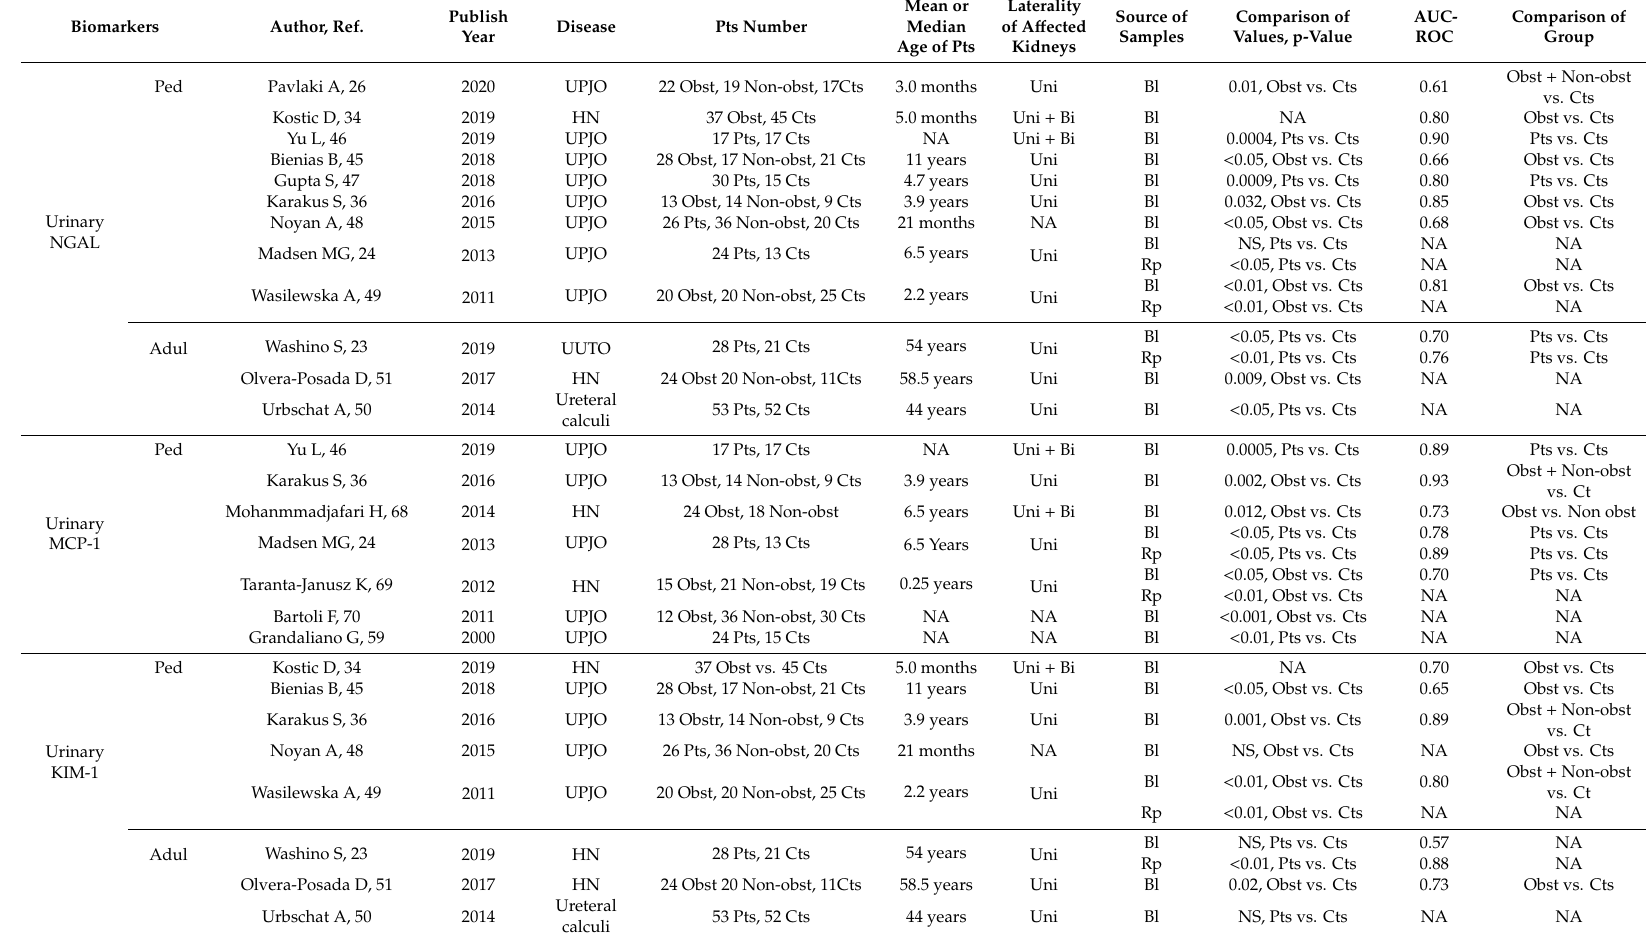
Table 1. Urinary and serum biomarkers for pediatric and adults